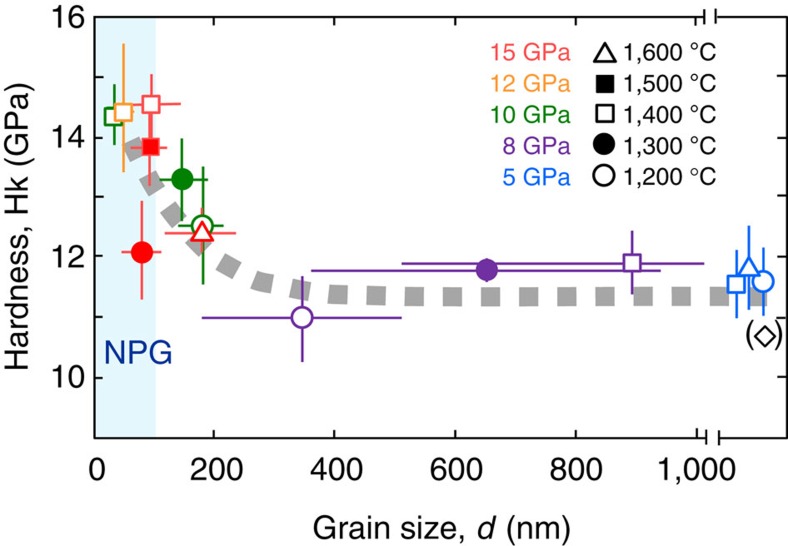
Knoop hardness versus grain size of the polycrystalline grossular.The Knoop hardness (Hk) increases with reducing grain size (d) particularly those below 200 nm, suggesting the Hall–Petch effect is applicable to nano-polycrystalline grossular, while no obvious relations of the hardness with either pressure or temperature are noted. Pressures are shown in different colours, while temperatures are shown by different symbols, as indicated in the figure. Open black diamond symbol in a parenthesis represents the hardness of a single crystal of natural grossular with a small (<1 wt%) amount of FeO and MnO (Methods). The hardness data of the samples with d>1,000 nm do not correspond to the scale of the horizontal axis, but are plotted in the order of the grain size. The shaded area indicated by NPG (nano-polycrystalline garnet) corresponds to the nano-crystalline region. The measured values of hardness and grain size are listed in Supplementary Table 1, with s.d.'s shown by error bars in this figure.